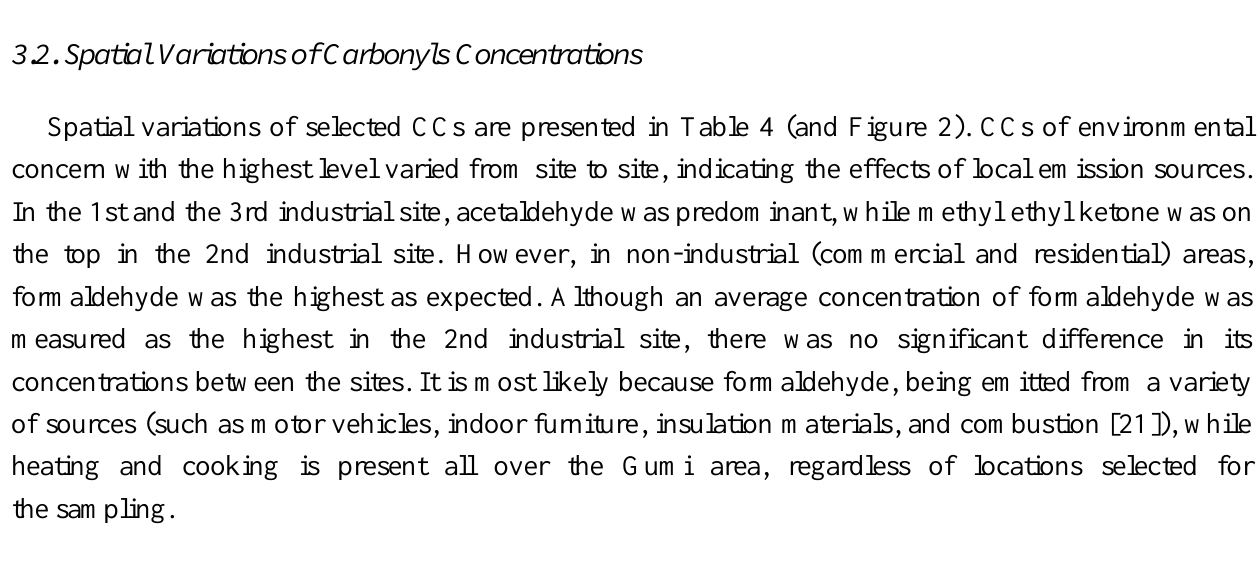
Table 4. Concentrations (ppb) of carbonyl compounds at each sampling site in Gumi city.